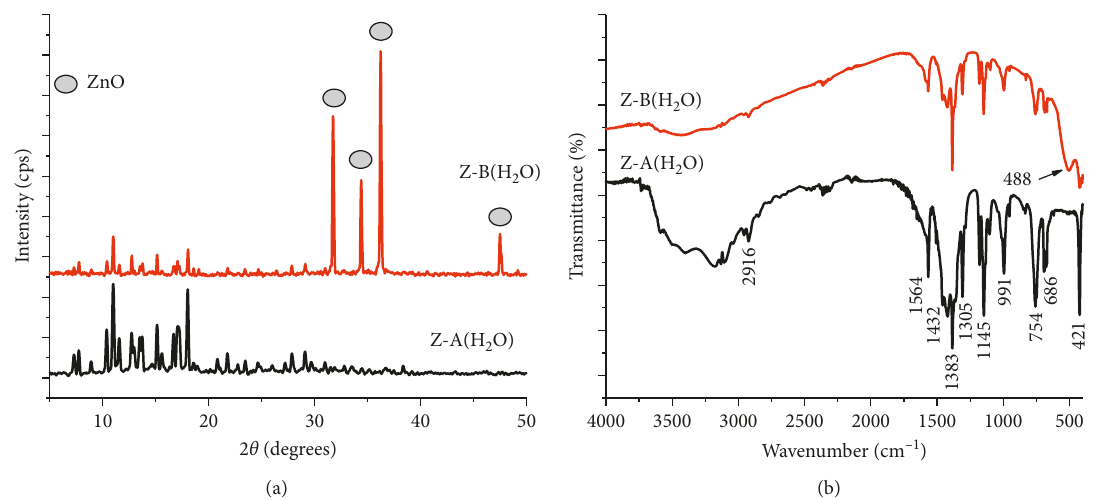
Figure 4: (a) XRD patterns and (b) FT-IR spectra of ZIF-8 synthesized in water.